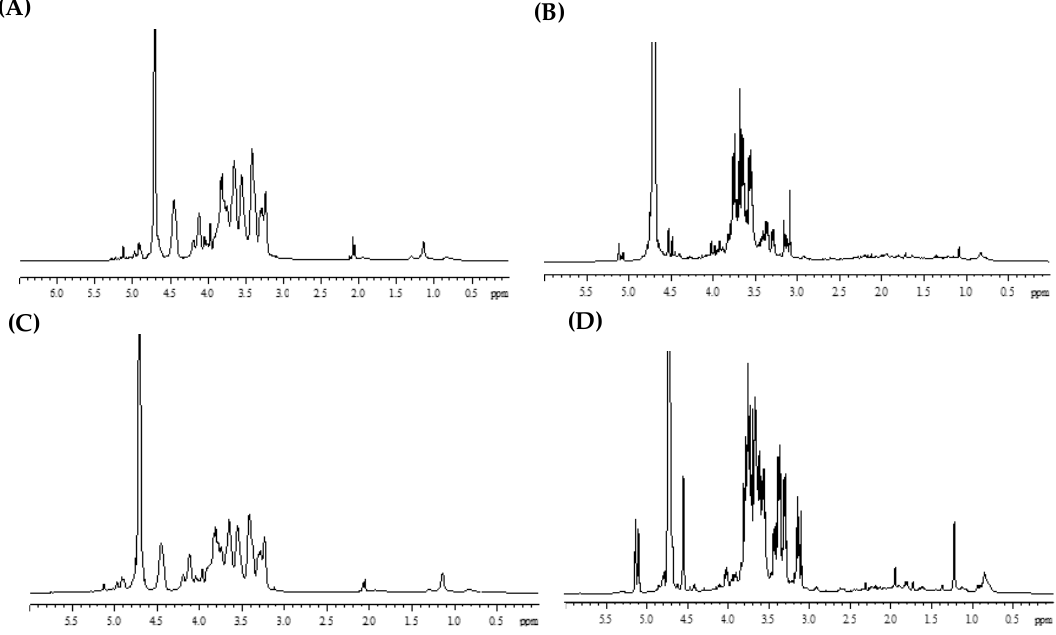
Figure 3. 1 H NMR spectra of dialyzed extracts from hot water extraction (HWE) and rapid solid-liquid dynamic extraction (RSLDE): HWE IN ( A ), HWE OUT ( B ), RSLDE IN ( C ), and RSLDE OUT ( D ).